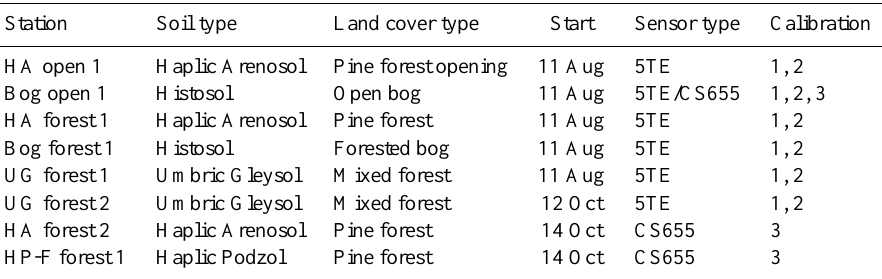
Table 1. Stations names, representative soil, and land cover types and start of observations as month/year. The sensor types are given as Decagon Devices Inc. 5TE (5TE) and Campbell Scientific Ltd. CS655 (CS655). The last column provides calibration curve information; 1 is factory calibration for mineral soil for 5TE, 2 is custom calibration for organic soil for 5TE (Bircher et al., 2016), and 3 is factory calibration for mineral soil for